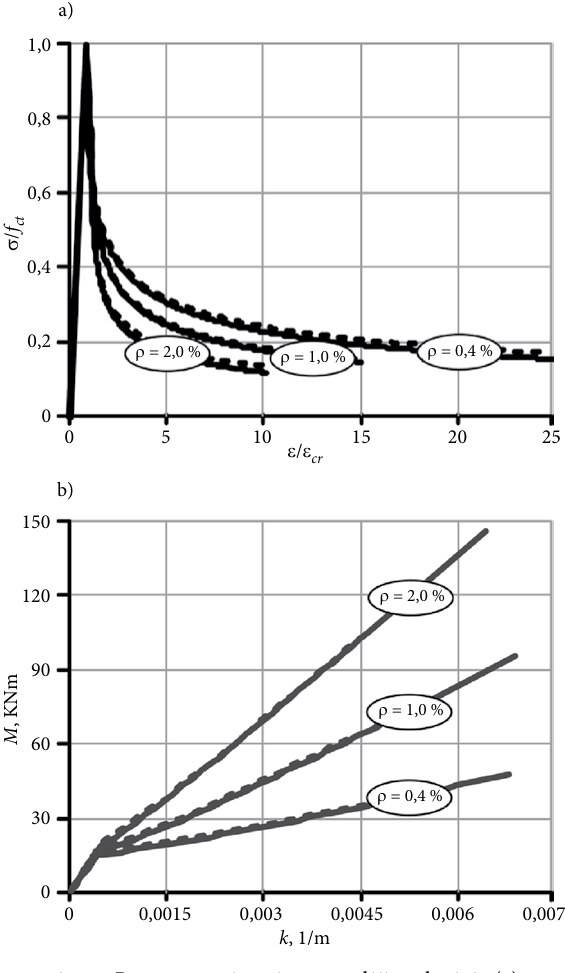
Fig. 9. Tension stiffening curves